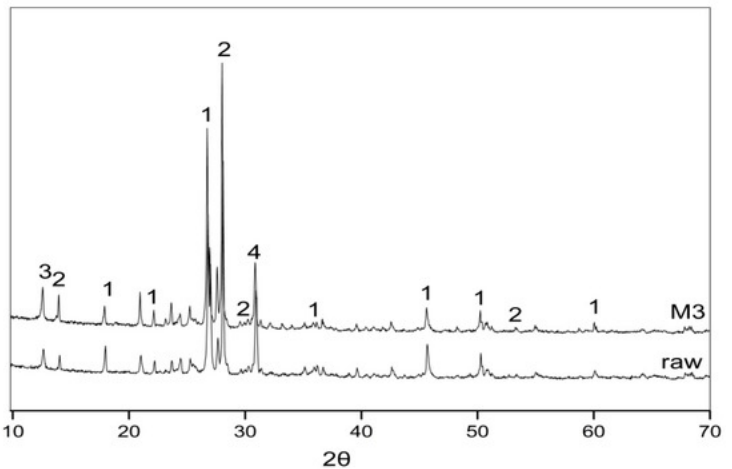
Figure 12. XRD result of raw copper-mine tailings and sample M3 (after 3 h of grinding) (1 quartz, 2 albite, 3 chlorite, 4 dolomite) [72].